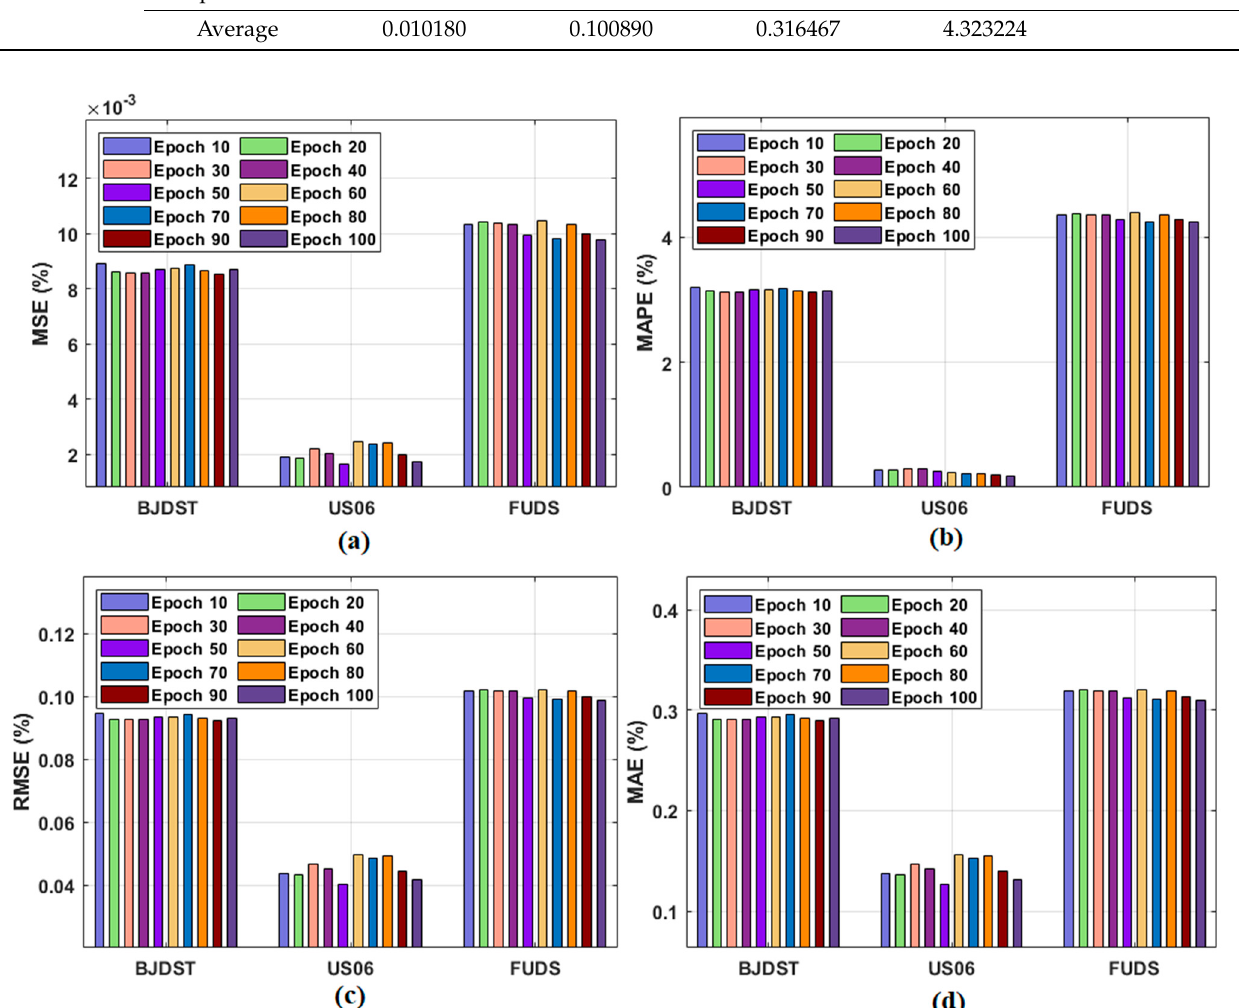
Figure 3. Result analysis of DLSOC-REM technique with varying epochs and drive cycles. ( a ) MSE, ( b ) MAPE, ( c ) RMSE, and ( d ) MAE